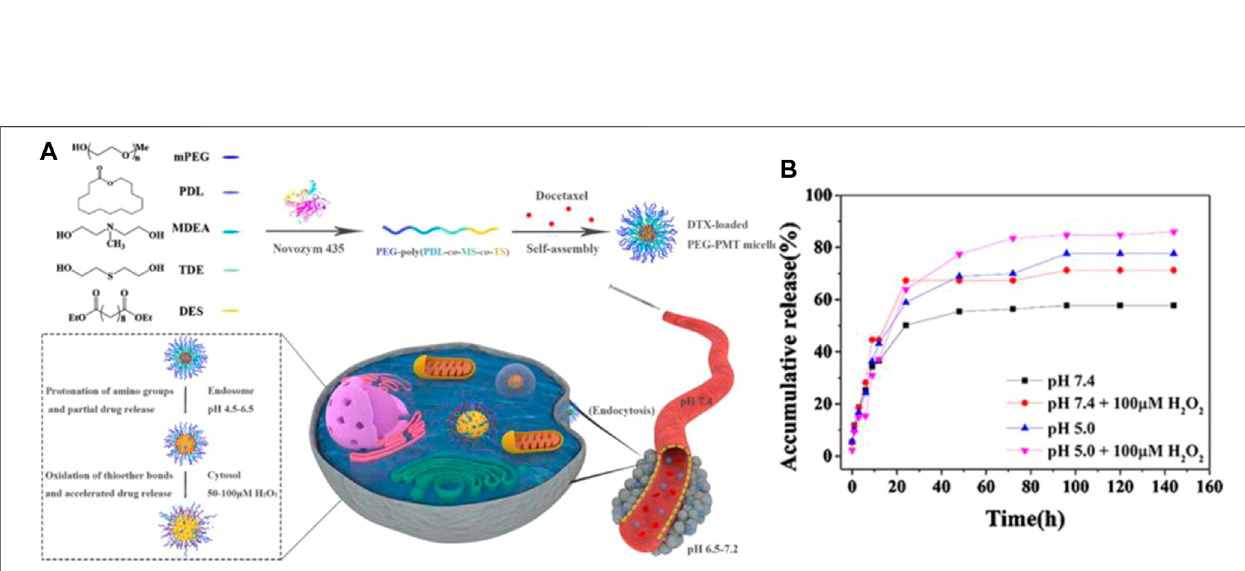
FIGURE 5 | (A) The preparation of PEG-PMT nanoparticles and schematic diagram of ROS/PH responsive micelles for DTX delivery in tumor cells. (B) Cumulative release of DOX from DTX-loaded PEG-PMT micelles in the presence of the different pH (5.0 and 7.4)100 μ M H 2 O 2 at different time (Su et al., 2020). Copyright 2020,